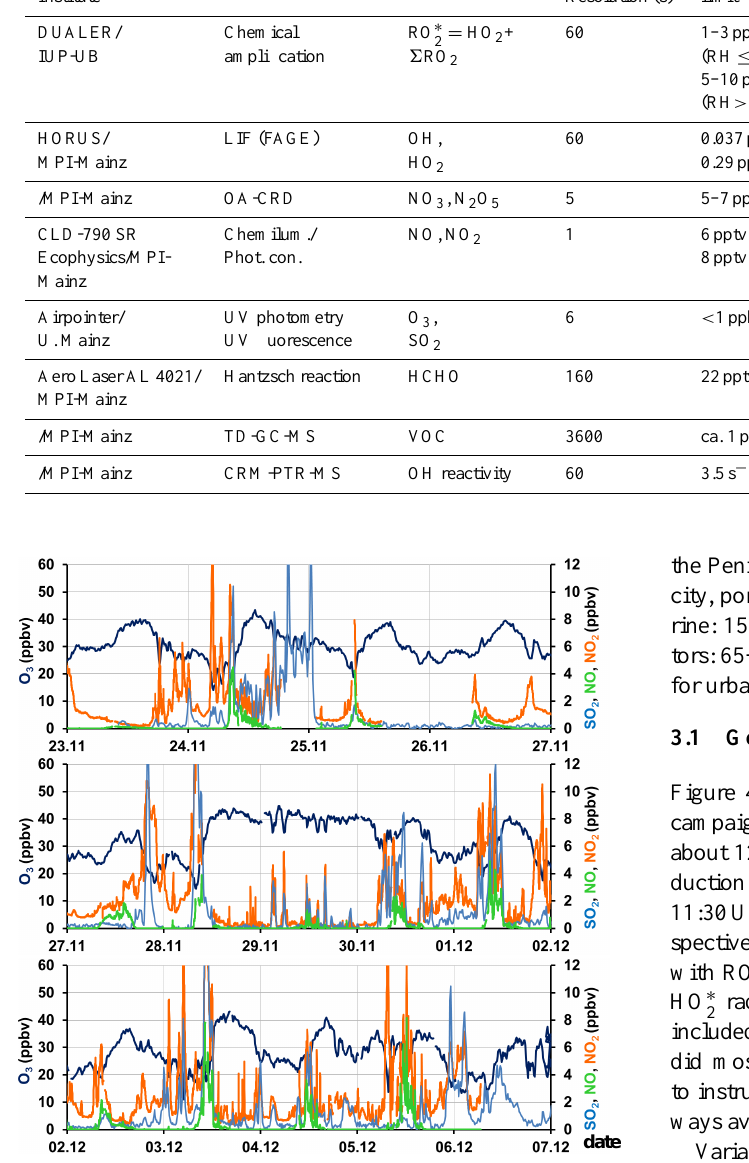
Fig. 2. Time series of selected trace gases measured during